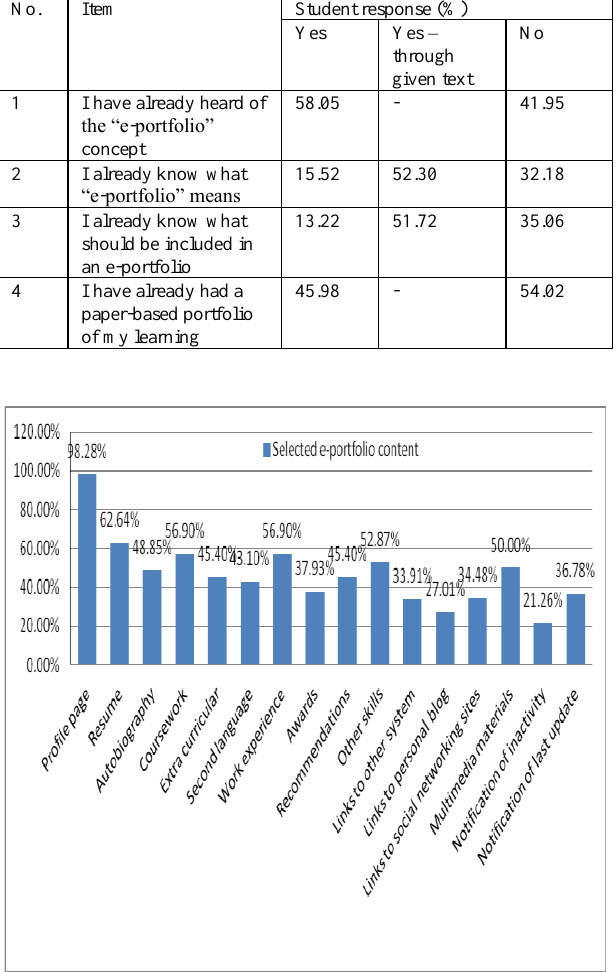
Figure 8. Preferred e-portfolio content